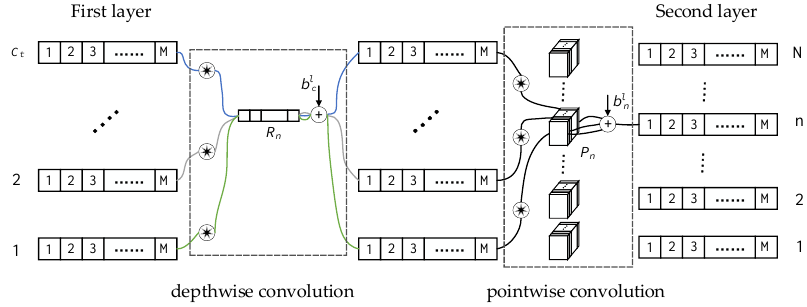
Figure 6. Illustration of improved DSC module.